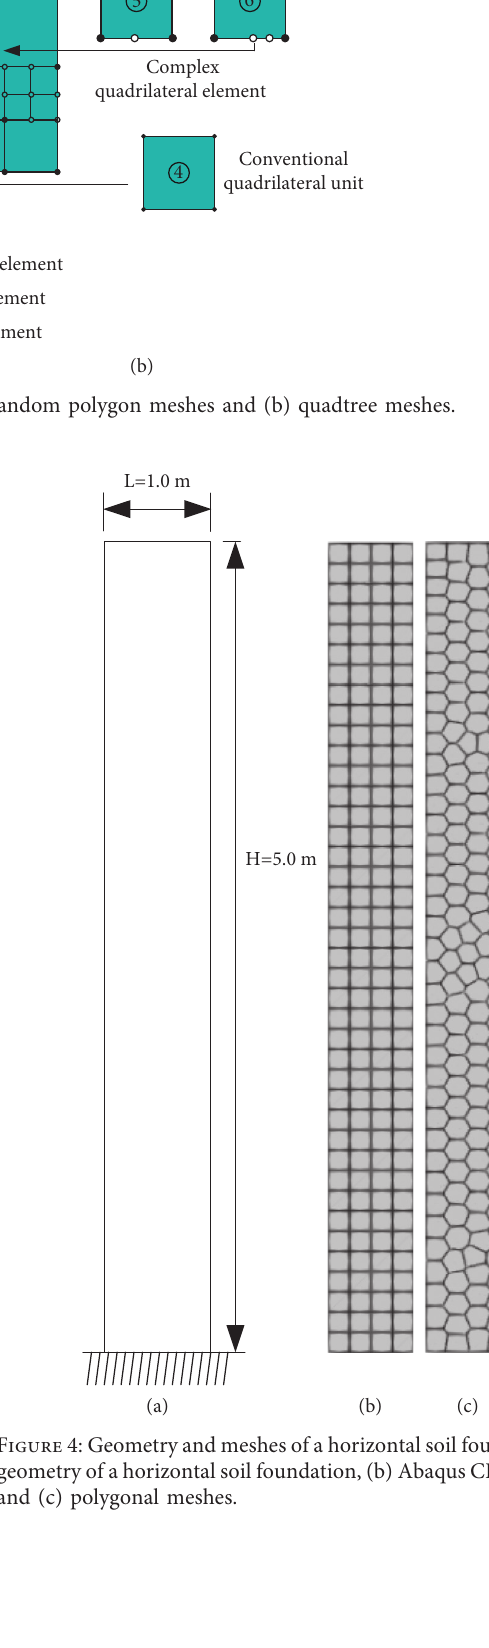
Figure 4: Geometry and meshes of a horizontal soil foundation: (a) geometry of a horizontal soil foundation, (b) Abaqus CPE4 meshes, and (c) polygonal